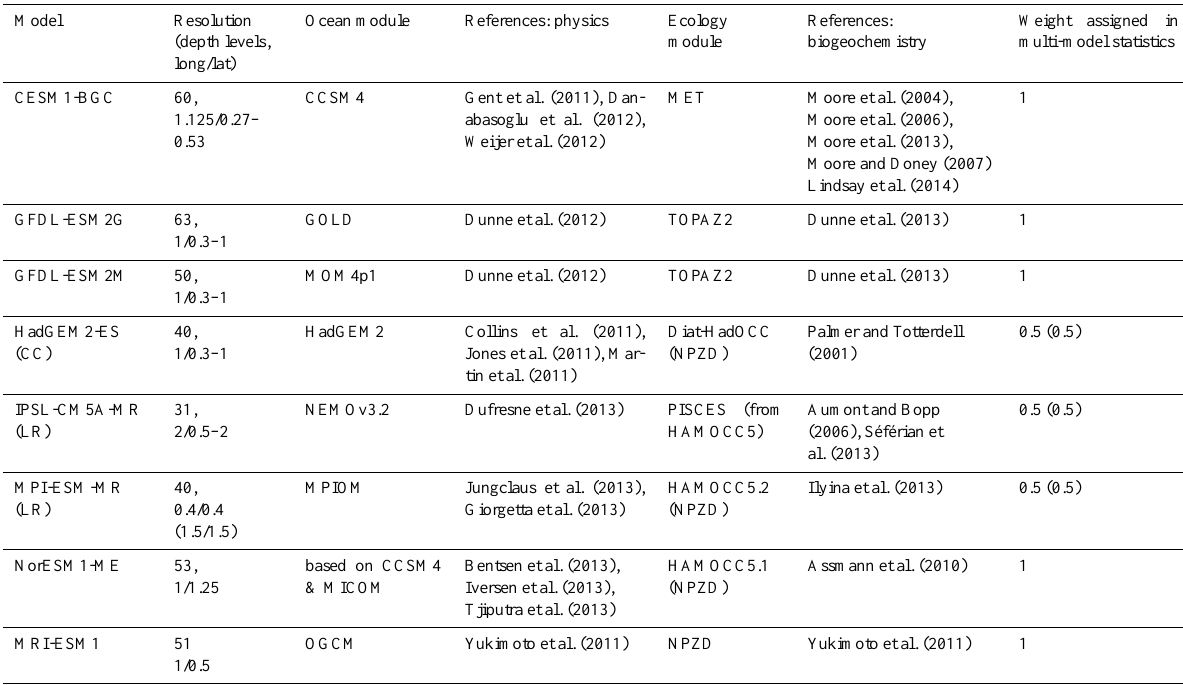
Table A1. Summarized information across CMIP5 models. The table includes: spatial resolution in the ocean, ocean module, ecology subroutine, phytoplankton types, references, and weight applied in the multimodel averages (see Methods). The major differences between HadGEM2-ES and -CC are the inclusion of an interactive tropospheric chemistry component in -ES, and different vertical atmospheric resolution in -ES (L30) and -CC (L60). The only difference between IPSL-CM5A-LR and -MR is the atmospheric horizontal